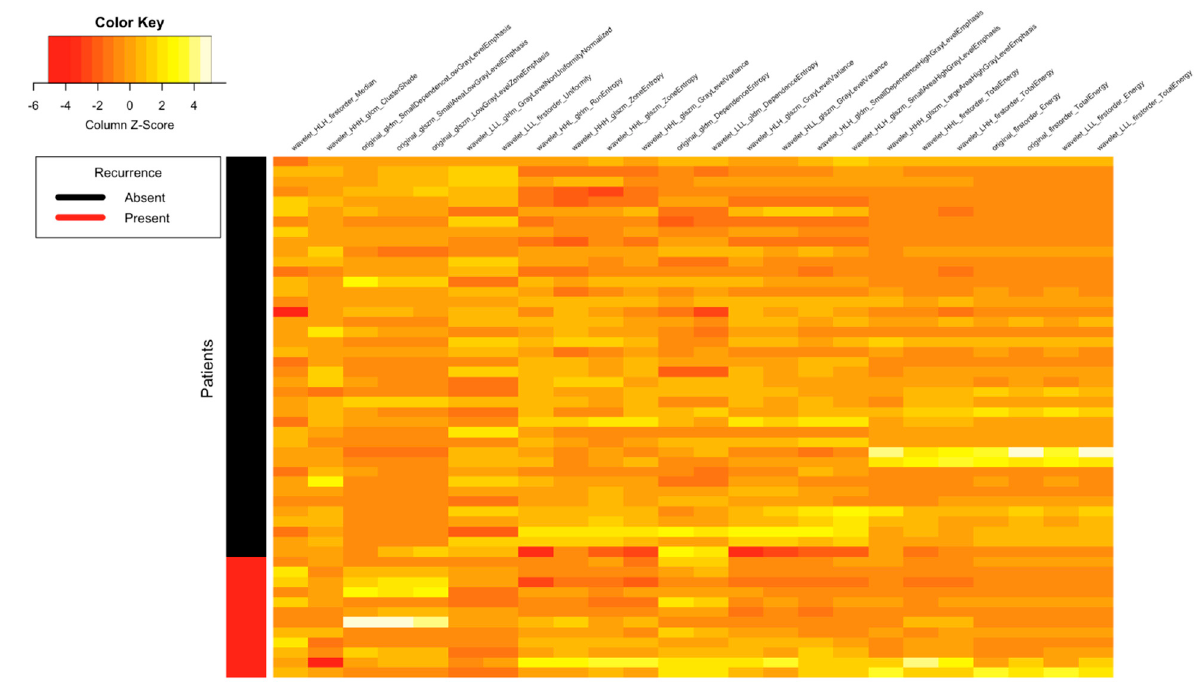
Figure 2. Heat map showing correlation between different radiomics and ADC features with the two classes of distant metastasis (absent and present).